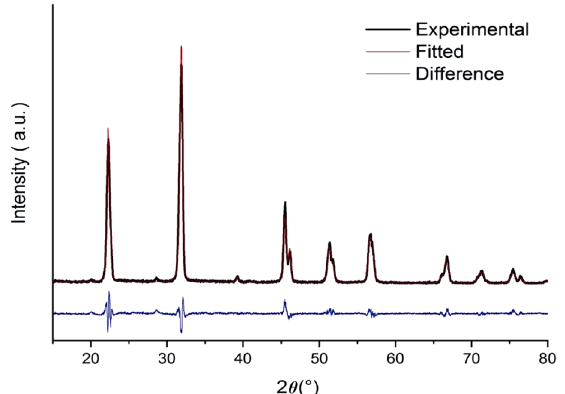
Fig. 2 Rietveld refinement of the XRD pattern of the pure KNN sample.